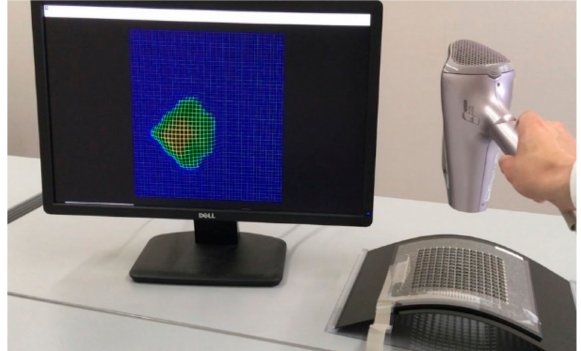
Figure 7. Result of wind pressure distribution imaging by using the developed sensor